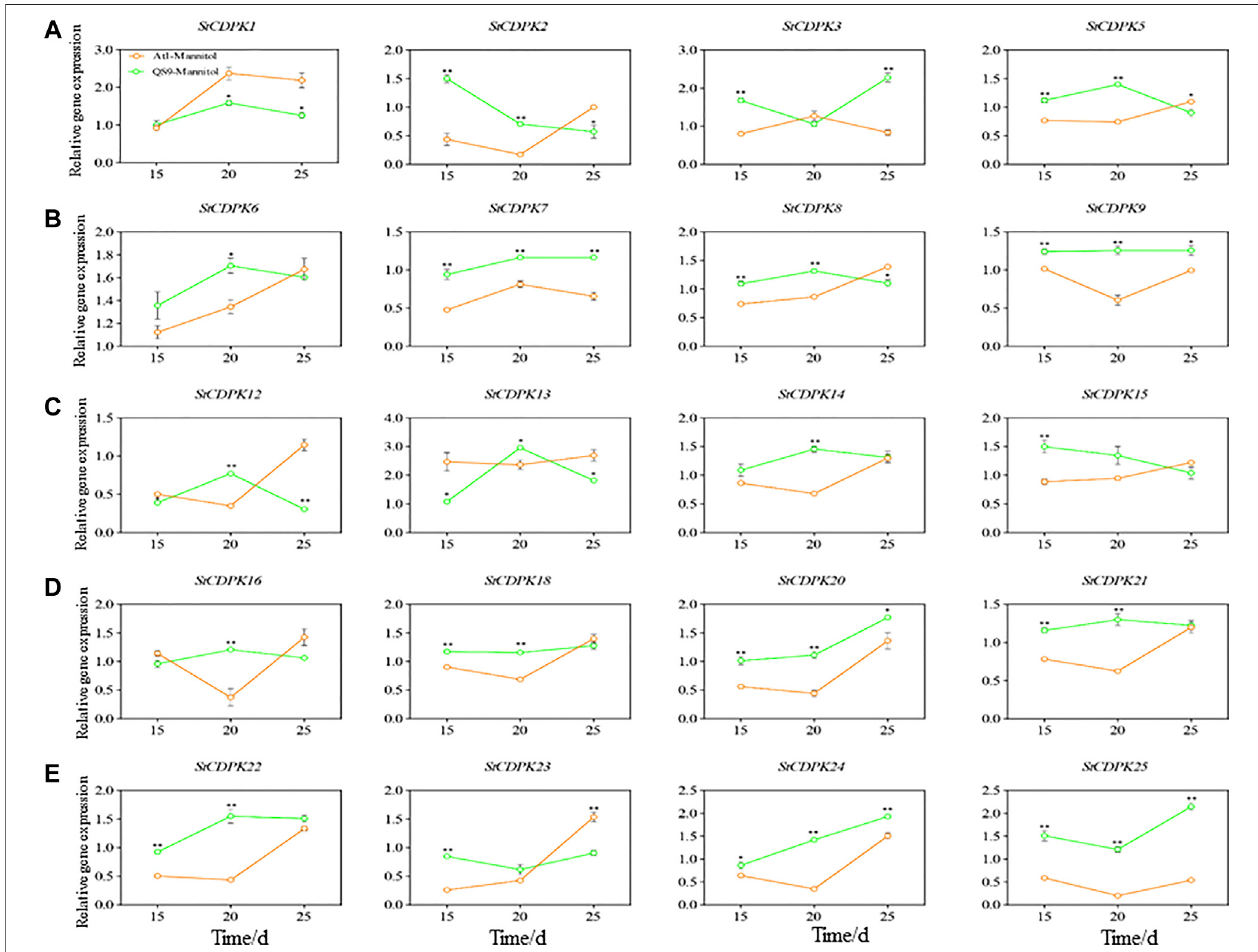
FIGURE 7 | (A-E) Changes of StCDPKs relative expression in potato during different periods under long-term drought. Expression patterns of 20 CDPK genes by quantitativePCRanalysesat15,20,and25 days,respectivelyinbothtolerantanddrought-sensitivecultivar.TheGreenandorangelinerepresentsQS9andAtlantic(Atl) cultivars, respectively. The actin gene was used as the internal control